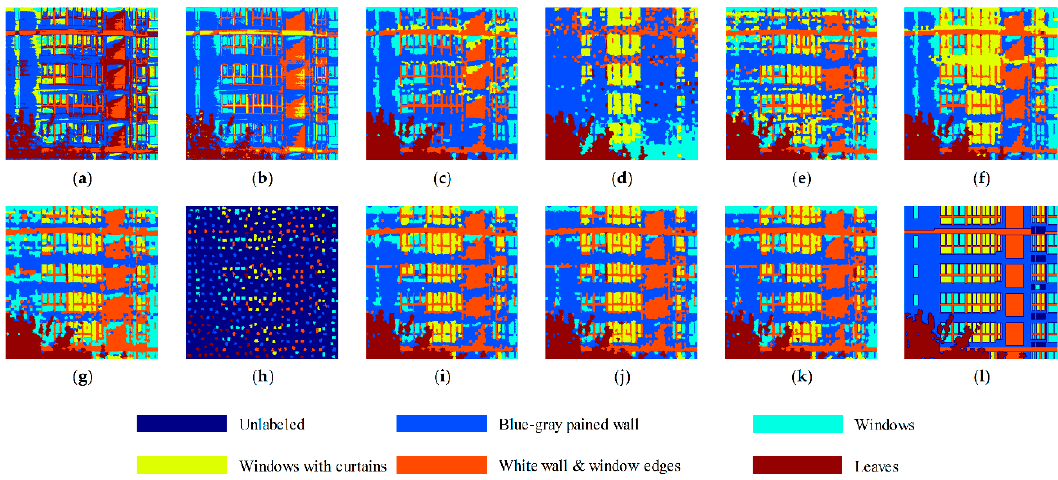
Table 3. Quantitative evaluation of the different clustering algorithms of dataset B.